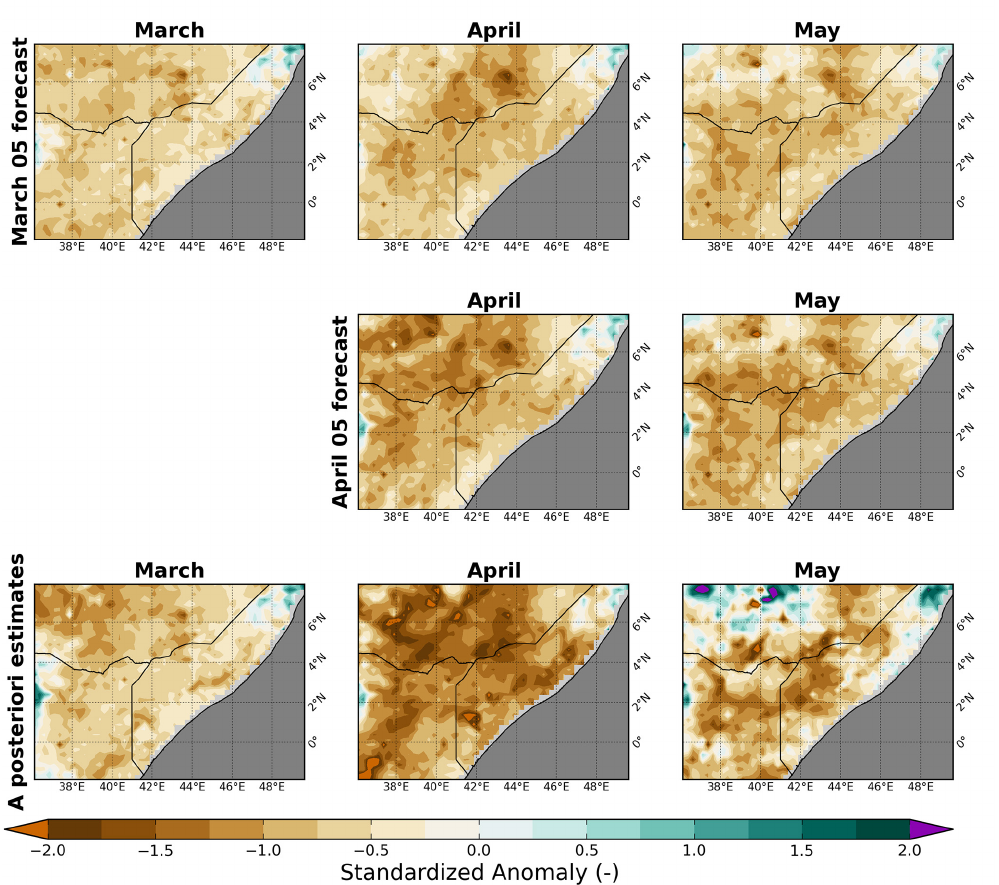
Figure 10. Comparison of standardized anomaly of SM forecast generated using CFSv2-based seasonal climate scenarios with SM a poste- riori estimates during the MAM season of the year 2011. Top panels show March–May forecasts generated on 5 March, middle panels show the same for April and May generated on 5 April and bottom panels show the SM a posteriori